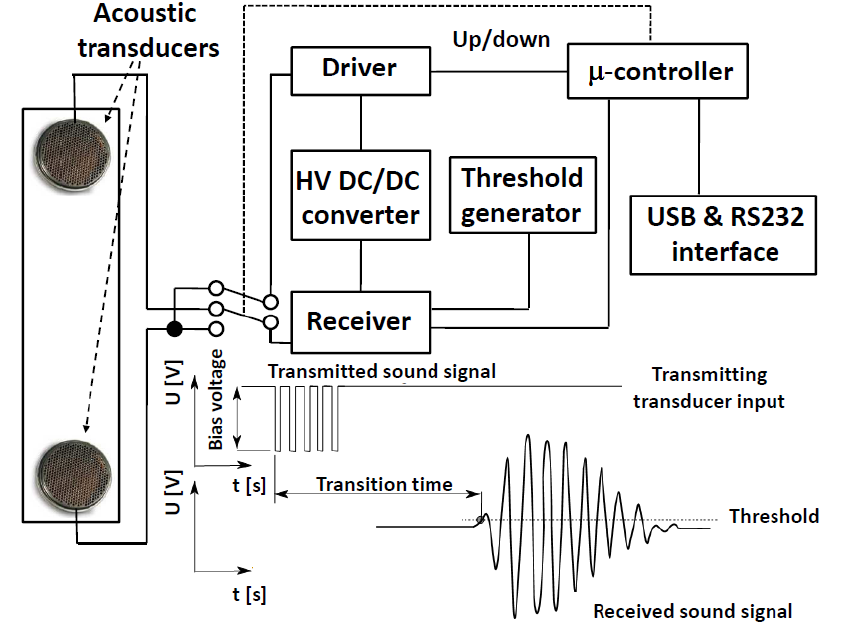
Figure 2. An illustration of the ultrasonic signal transit time measurement and the electronic readout block diagram is shown for a design that allows the transducer roles to be swapped for more precise calibration and for simultaneous gas velocity measurement.